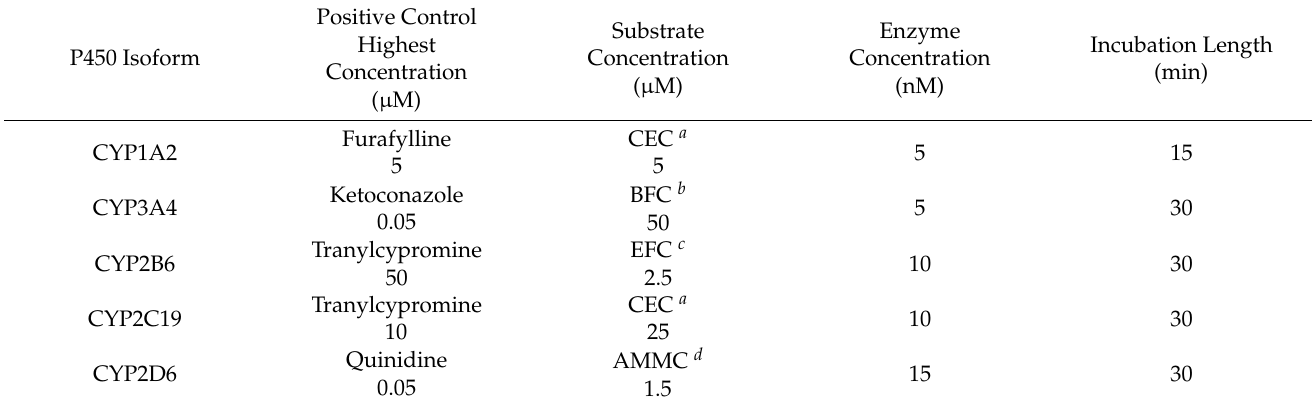
Table 5. Experimental conditions summary—cytochrome P450 IC 50 inhibition determination